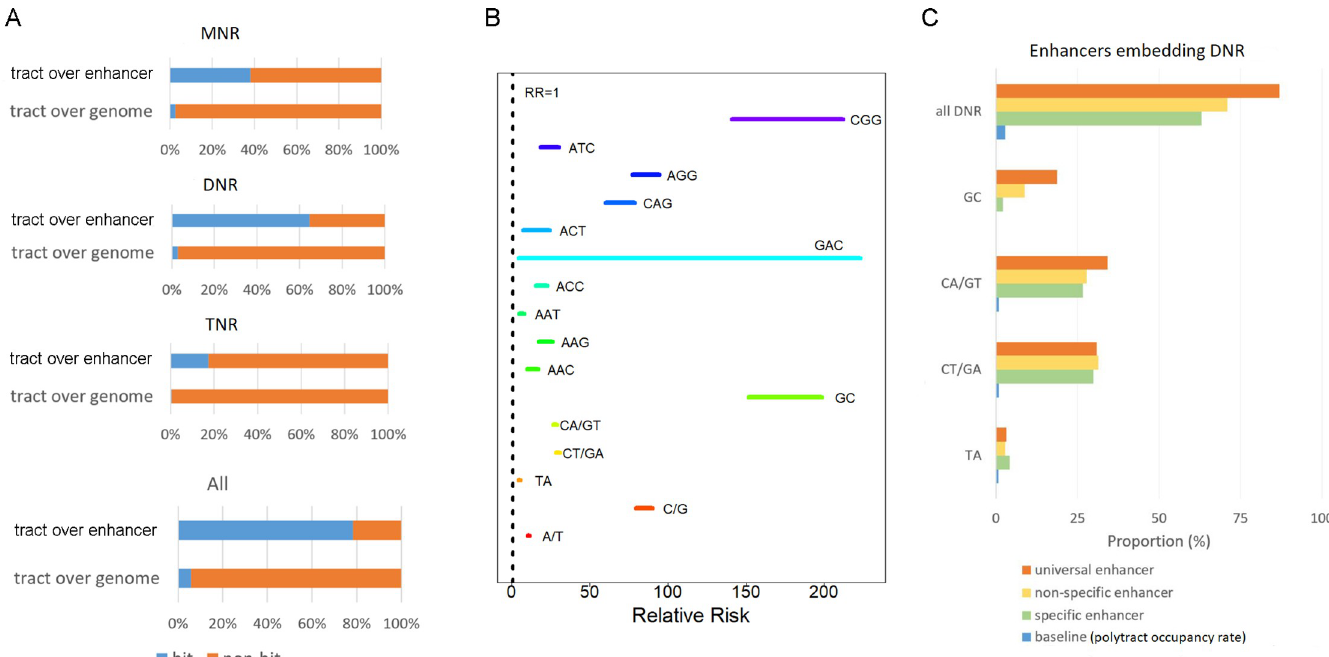
Fig 2. Enhancers are significantly enriched with polytracts. A, proportion of enhancers embedding polytracts (“tract over enhancer”) largely surpasses the baseline proportion (“tract over genome”), obtained through dividing polytract nucleotide quantity with the total size of the reference genome. B, polytracts’ 95% confidence interval of Relative Risk of being embedded in enhancers. C, association rate for universal/specific enhancers with DNR. As a superset to “universal enhancer,” “non- specific enhancer” is complementary to “specific enhancer.” Baseline is included as the occupancy percentages of each DNR species in GRCh38.